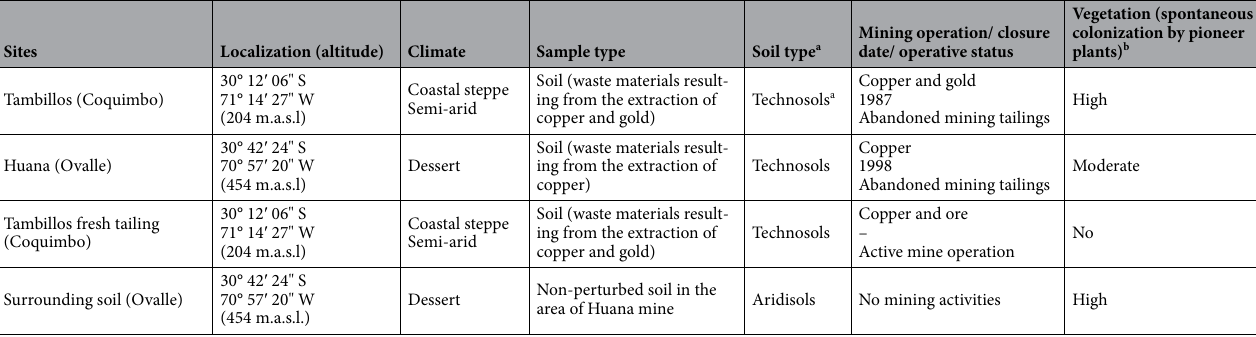
Table 1. Main description of studied sites. a Also classified as Thionic-Technosols due to their high levels of sulphidic materials. b Two of the most abundant native species found in both tailings were Baccharis linearis (Romerillo, 19% cover) and Haplopappus parvifolius (Bailahuén, 1% cover) 17 . Neither forestation nor direct vegetation managements have been applied in the